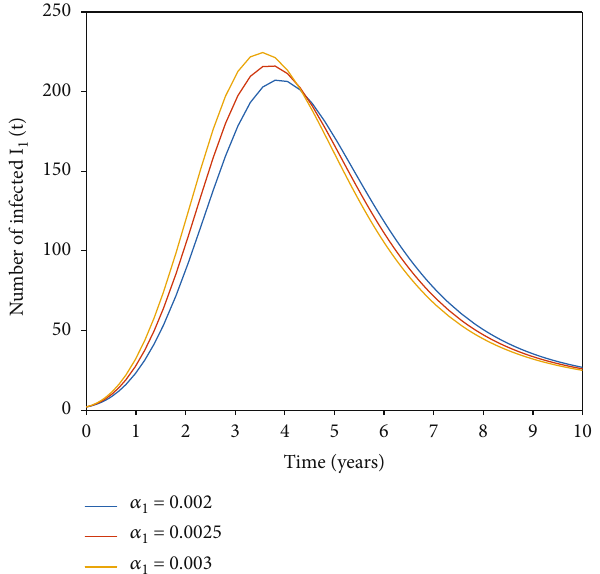
Figure 15: Transformation of infected individuals for varied infection rate α 1 .